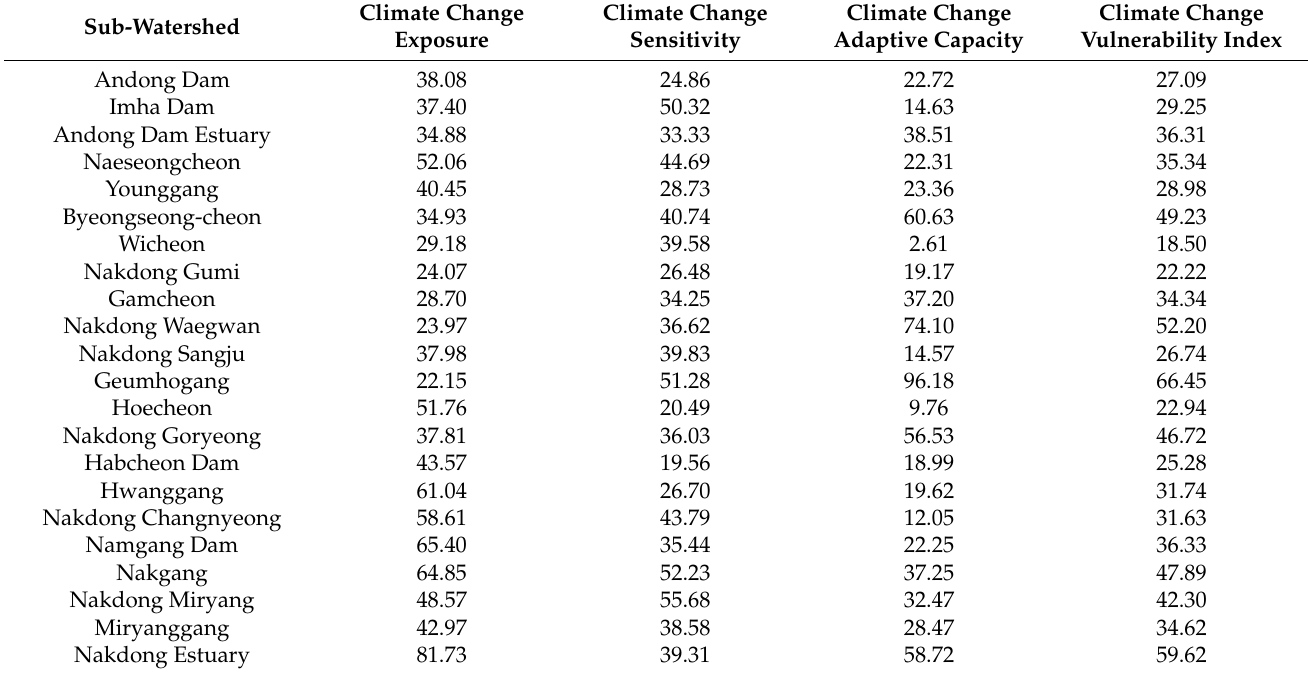
Table 14. Climate change vulnerability in the SSP-585